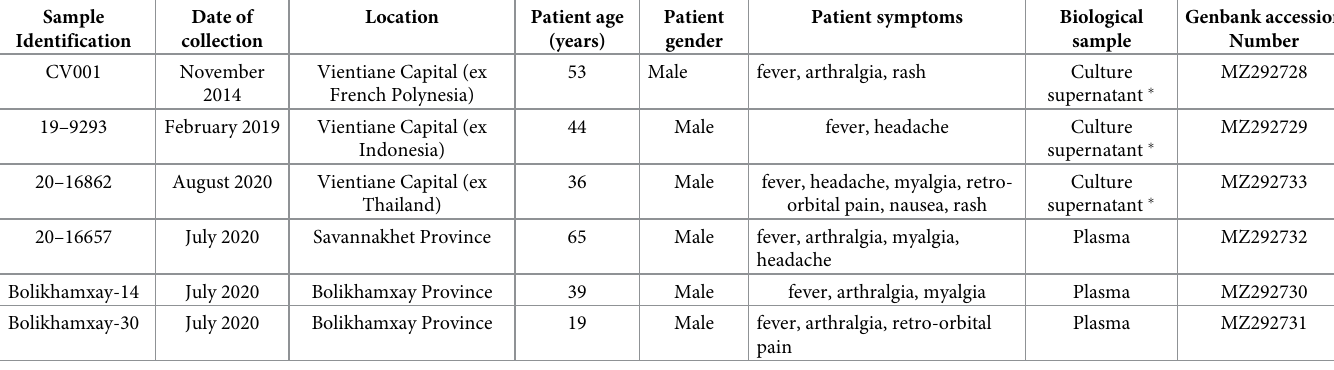
Table 1. Data relative to the Lao CHIKV strains included in the phylogenetic